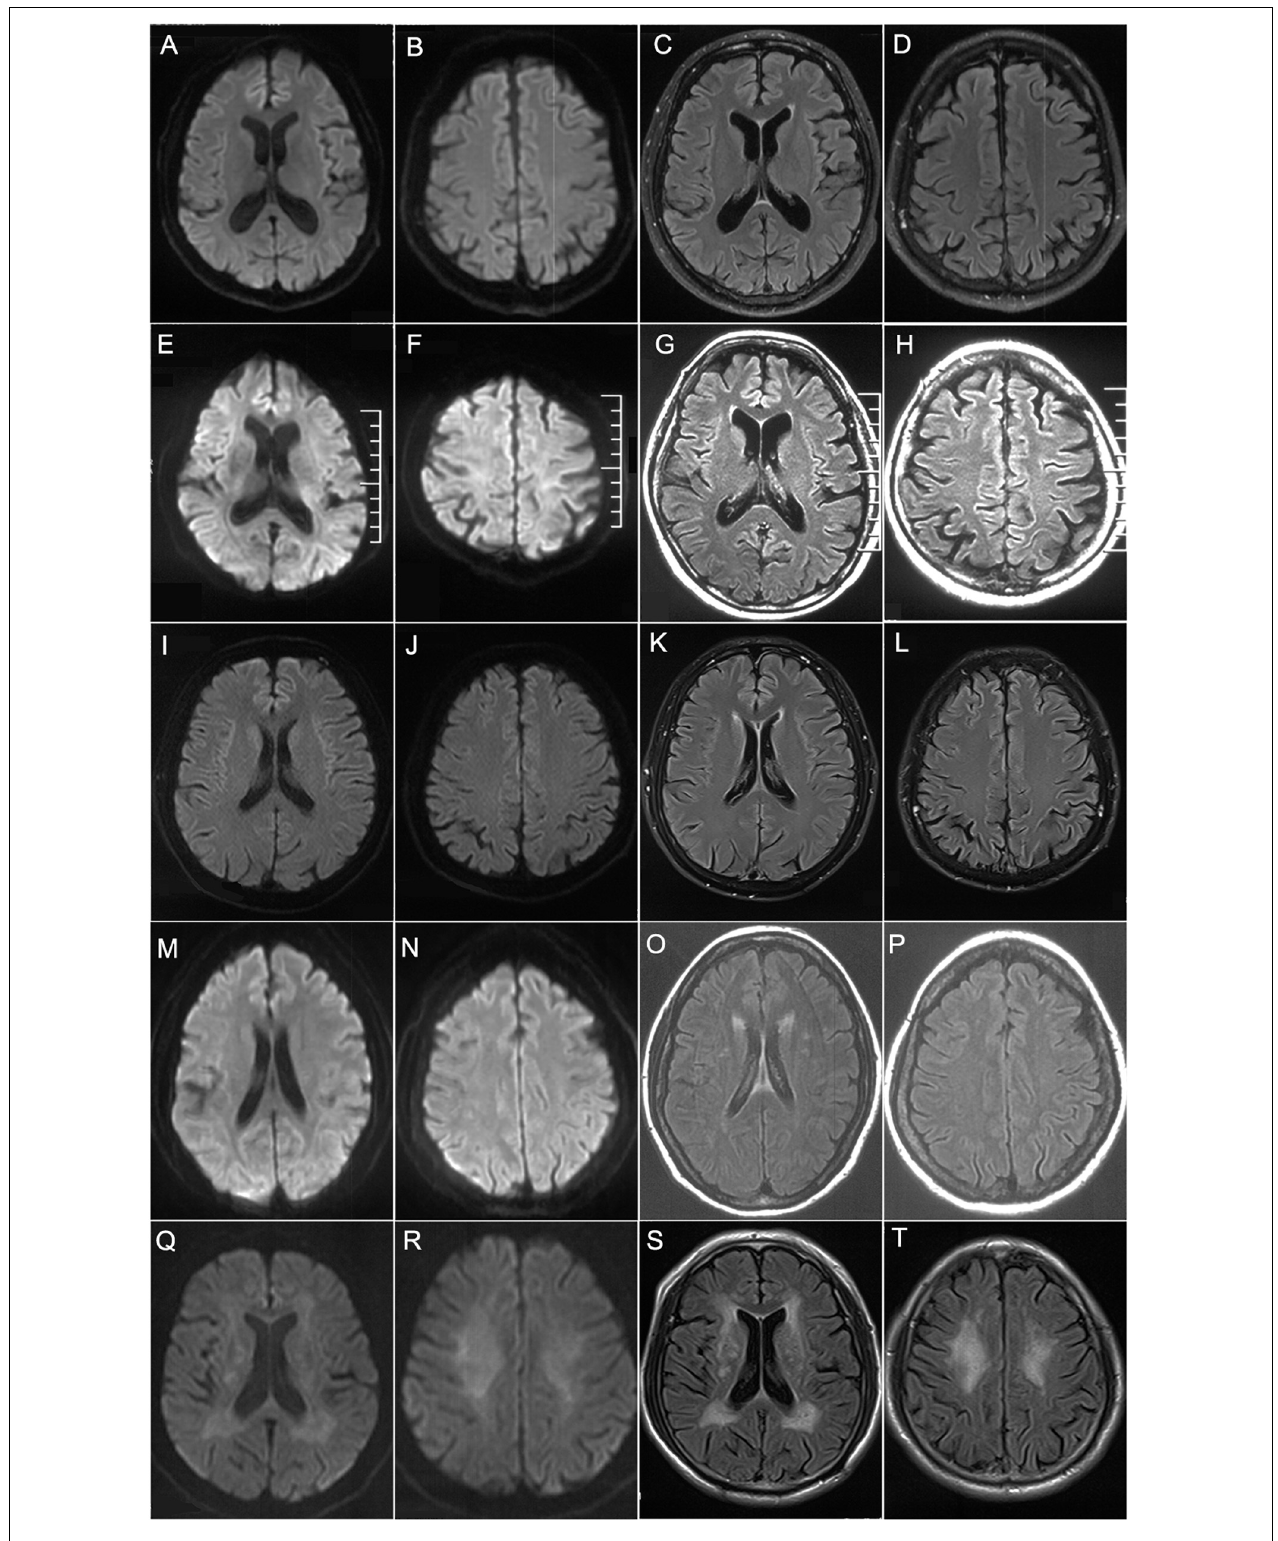
FIGURE 3 | Brain MRI findings. Brain MRIs of patient 1 (A–D) , patient 2 (E–H) , patient 3 (I–L) , patient 4 (M–P), and patient 5 (Q–T) . (A–L) showed no obvious abnormalities on DWI (A,B,E,F,I,J) or T2-FLAIR (C,D,G,H,K,L) . (O,P,S,T) showed high signals along the lateral ventricle on T2-FLAIR while no obvious abnormalities on DWI (M,N,Q,R)